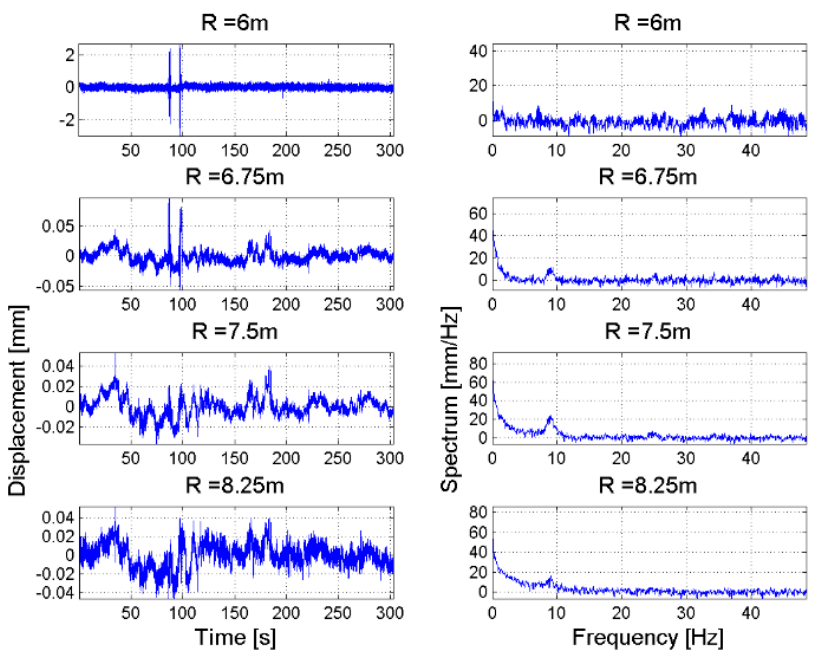
Figure 19. San Pietro dam, Aquilonia. ( left ) time series of displacements; ( right ) corresponding frequency spectrum of targets belonging to the chalice-shaped spillway located at range distance in the interval [5 m, 10 m].